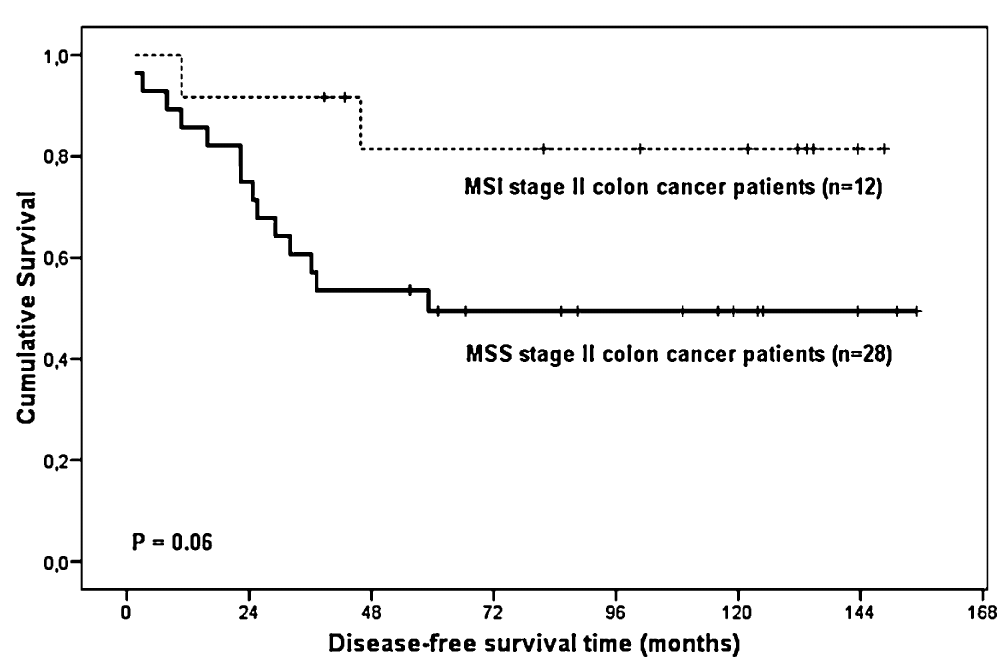
Fig. 1. Kaplan–Meier analysis of disease-free survival for 40 stage II colon cancer patients stratified by MSI/MSS status. MSI colon tumors showed a trend towards better disease-free survival compared to MSS patients ( p = 0 .